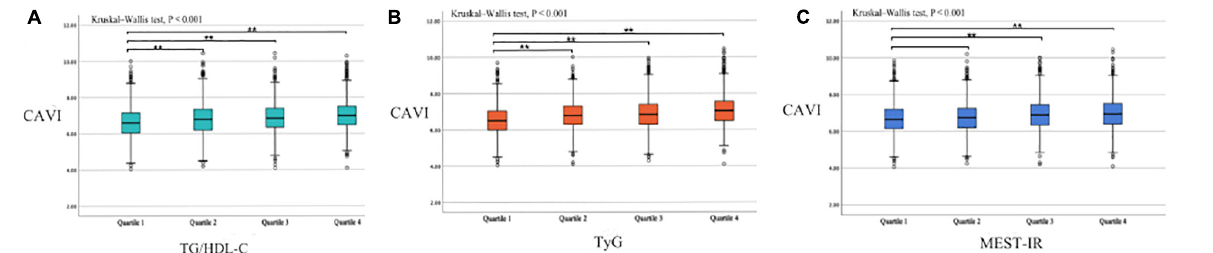
BMI, SBP, and DBP, all the non-insulin-based IR indices were still correlated with CAVI, and the partial correlation coefficients were 0.078 for TG/HDL-C, 0.114 for TyG, and 0.109 for